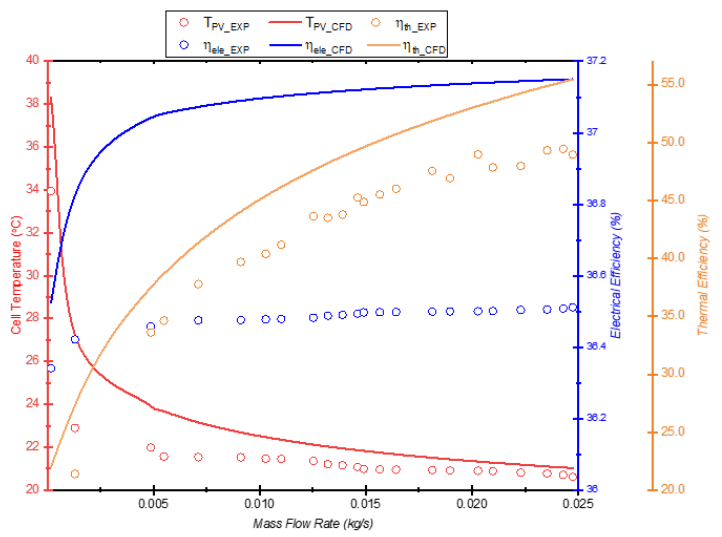
Figure 13. Changes in MJPV temperature, thermal efficiency, and electrical efficiency at different mass flow rates.